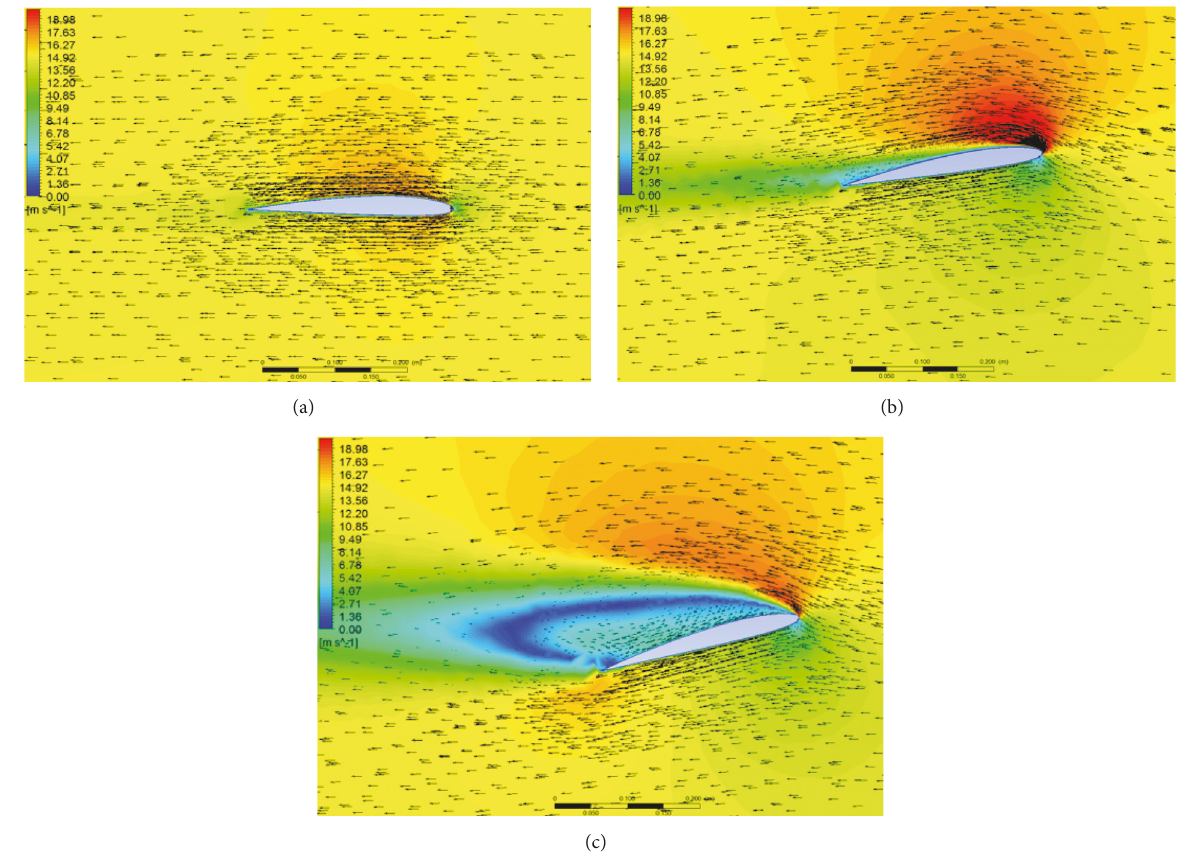
Figure 12: Velocity contour plots and wind velocity vectors (Re = 237 000) for (a) 0 ∘ AoA, (b) 12 ∘ AoA, and (c) 16 ∘